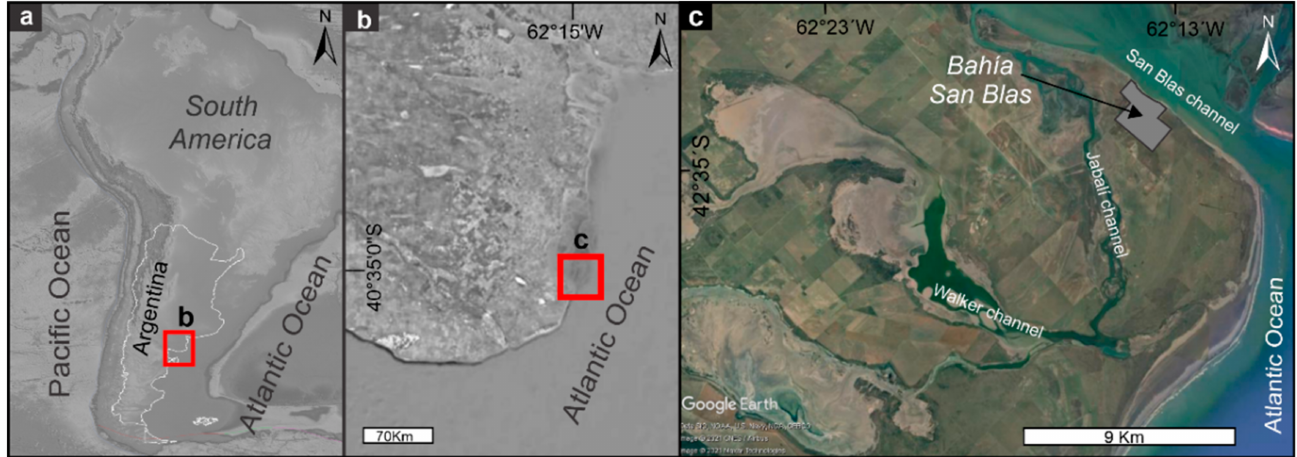
Figure 1. ( a ) Regional locations of the study area; ( b ) Location of the study area within the northern Patagonian coast, ( c ) Bahia San Blas